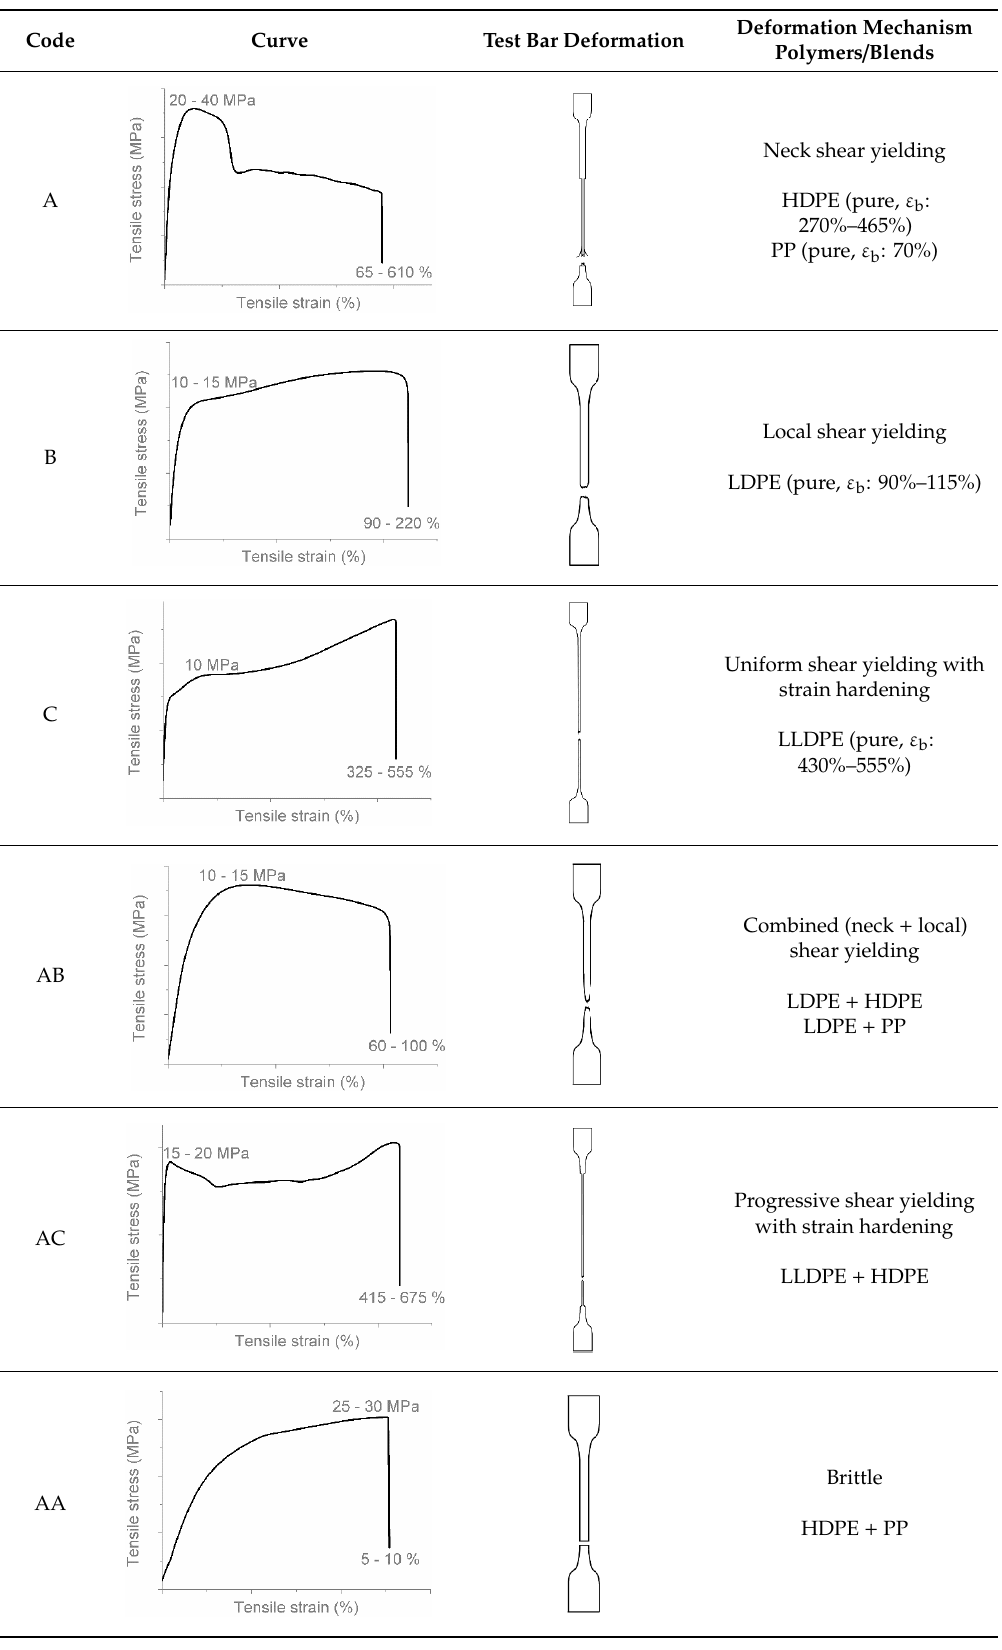
Table 4. Stress–strain curves with a representative code, schematic dog bone deformation, mechanism, and typical materials.